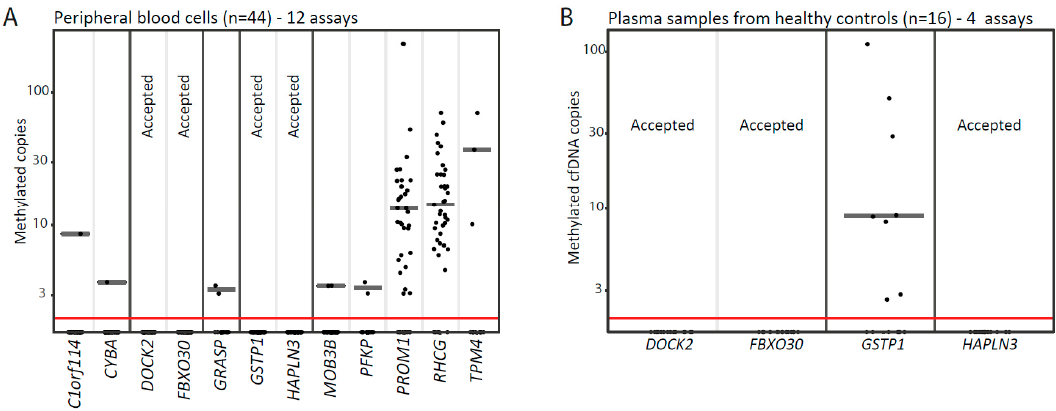
Figure 2. Evaluation of biomarker candidates using methylations-specific droplet digital PCR. ( A ) Twelve methylation-specific droplet digital PCR (MS-ddPCR) assays were tested on DNA from peripheral blood cell samples from healthy donors ( n = 44). ( B ) Four MS-ddPCR assays were further tested on cfDNA samples from healthy donors ( n = 16). Each dot represents one analyzed sample. Candidate genes with no signal are marked with Accepted. Median values are indicated with horizontal grey lines. cfDNA, circulating cell-free